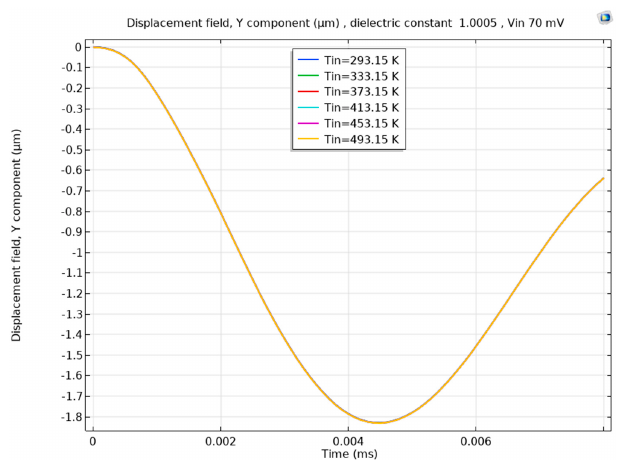
Figure 14. The effect of temperature change on the displacement of the beam at air-only conditions. The figure shows the beam deflection is almost the same. Hence, changes in the die electric constant are minimum against a signi fi cant temperature variation.